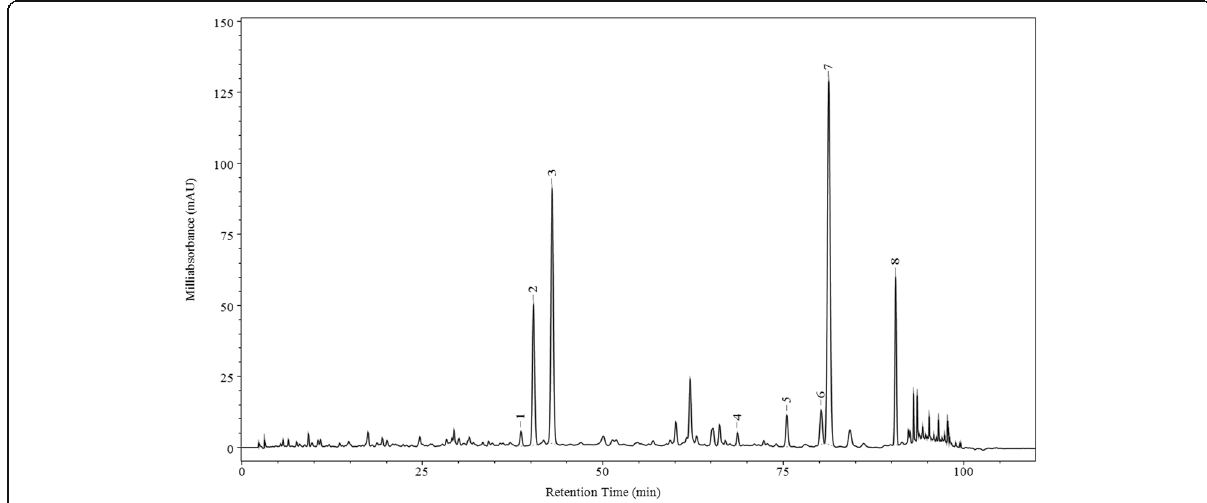
Fig. 1 Representative HPLC chromatogram of YYHs at 270 nm